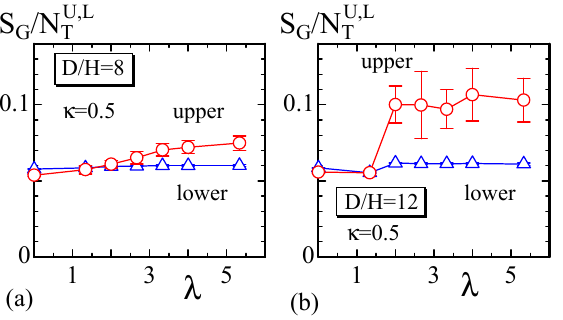
Figure 10. S G / N U , L vs. λ obtained on the disks of ( a ) D / H = 8 and ( b ) D / H = 12. The model for this T calculation has no constraint U vol .